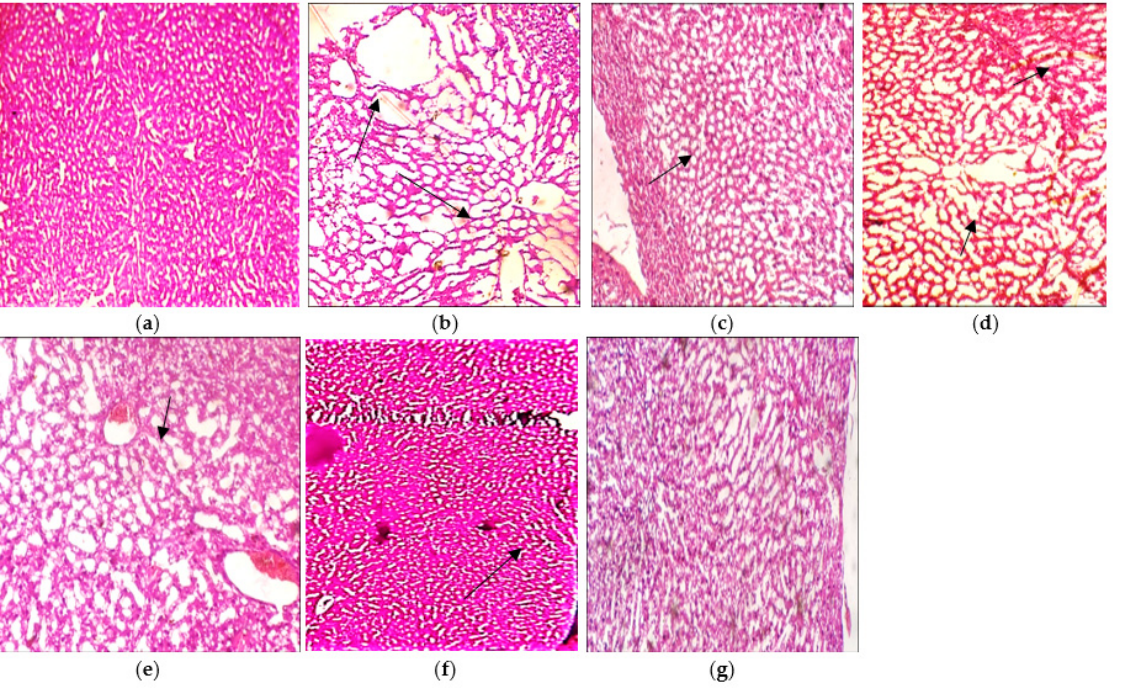
Figure 8. Histopathological results of liver tissues : ( a ) normal control group rat, ( b ) LPS intoxi- cated rat liver, ( c ) N. hindustana extract-treated group, ( d ) V. negundo treated group, ( e ) A. albiflora ethanolic extract-treated group, ( f ) conjugation of N. hindustana , V. negundo , and A. albiflora treated group, ( g ) brain section of the standard drug group. Objective size is 40 × . Arrows represent mononuclear cell infiltration with congested sinusoids due to the enlargement of hepatic capillaries